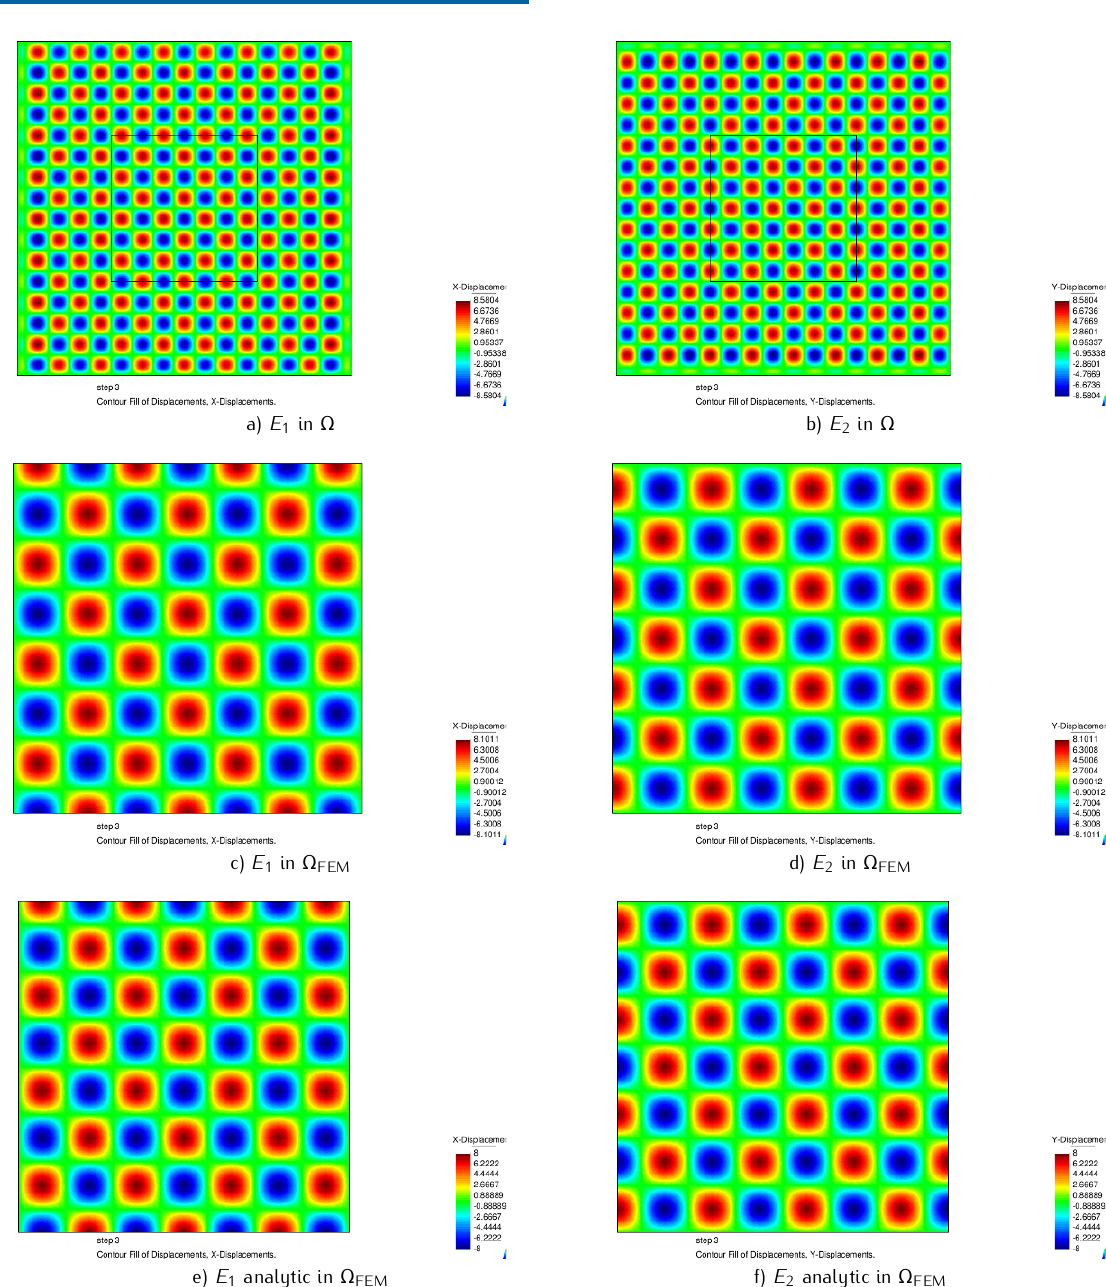
Figure 4. Test 1. Comparison of the analytic solution time moment t = 8 . 0 for A = 3 in (46) . We present: in a) and b) components ( E finite element solution in Ω